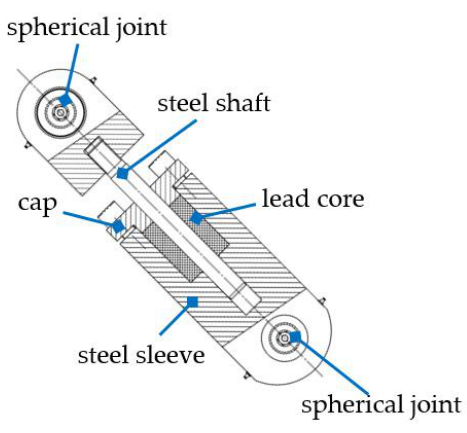
Figure 1. Sketch and nomenclature of the main elements of the PS-LED.